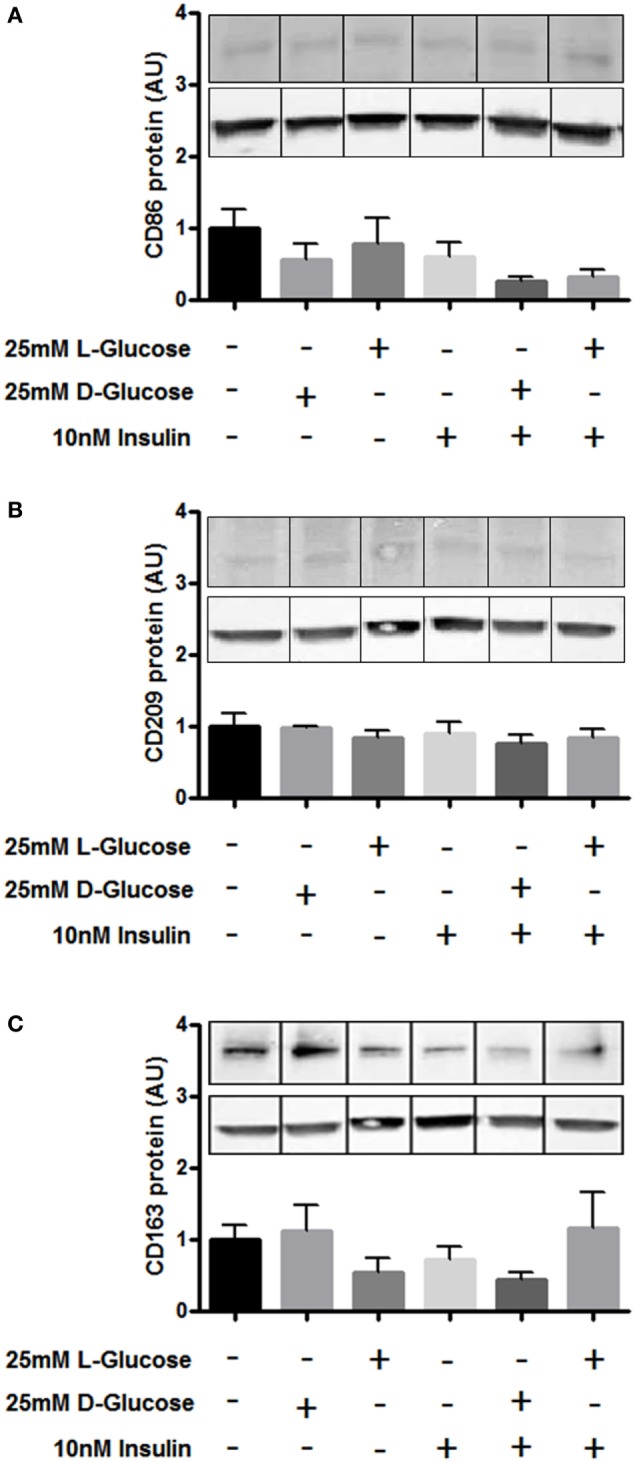
Surface marker expression on Hofbauer cells (HBCs) in response to hyperglycemia and insulin. (A) Protein level of M1 marker CD86 after exposure to glucose, insulin, and the combination of both. (B) Protein level of M2 marker CD209 after exposure to glucose, insulin, and the combination of both. (C) Protein level of HBC marker CD163 was not affected by exposure to glucose, insulin, and the combination of both. l-Glucose was used as osmotic control, cells cultivated in macrophage medium only were used as untreated control. Bar charts: pool of three individual experiments, one-way ANOVA; mean ± SEM. One out of three representative Western Blots shown. Western Blot images were cropped as gels were loaded with side-by-side duplicates of each treatment. β-Actin was used as loading control for normalization.